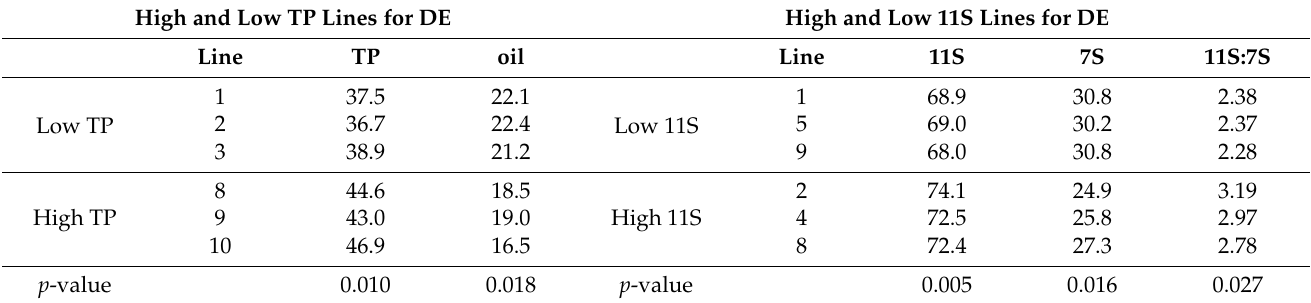
Table 1. The average seed protein and oil content (as a percentage of the seed weight) for the lines selected for high vs. low TP DE (lines 1, 2, 3 vs. lines 8, 9, 10). The average 11S and 7S content (as a percentage of total seed protein content) and the average ratio of 11S:7S from high 11S lines selected for high vs. low 11S DE analysis (lines 2, 4, 8 vs. lines 1, 5, 9). The p -values represent the statistical difference between high and low soybean groups for each attribute via two-tailed t